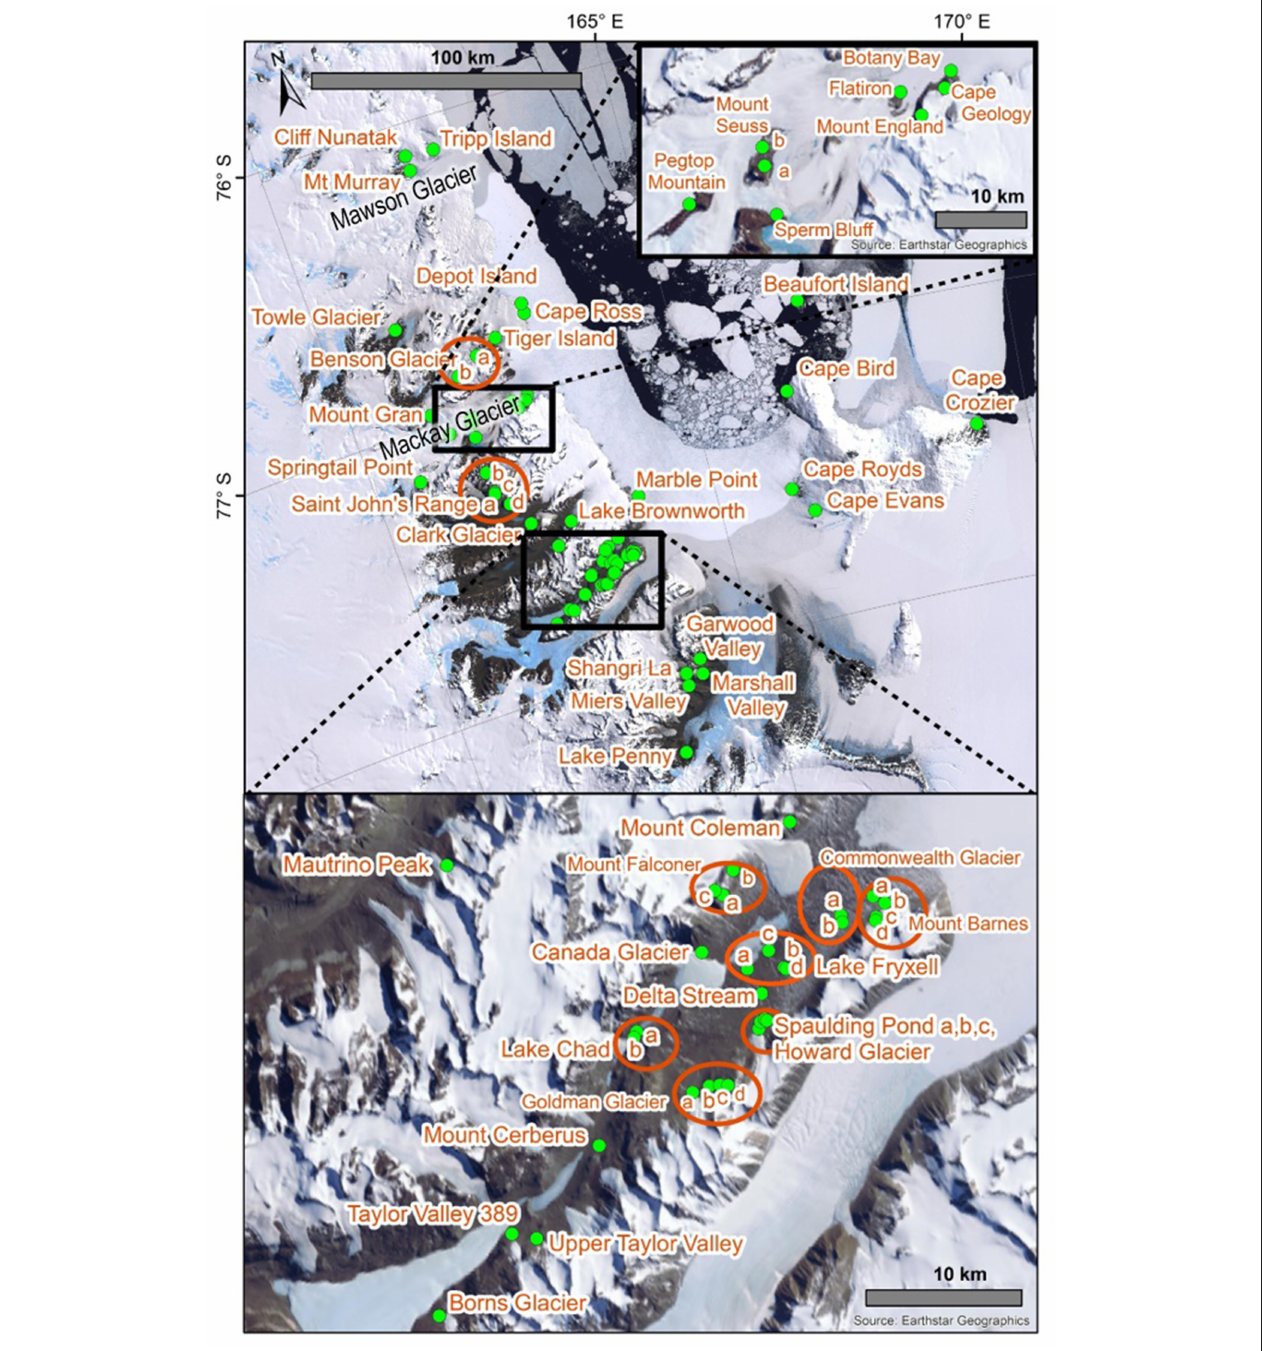
FIGURE 2 | Map with all 67 sites in southern Victoria Land labeled, generated in ArcMap v10.5.1. See Table 3 and Table S1 for GPS co-ordinates.